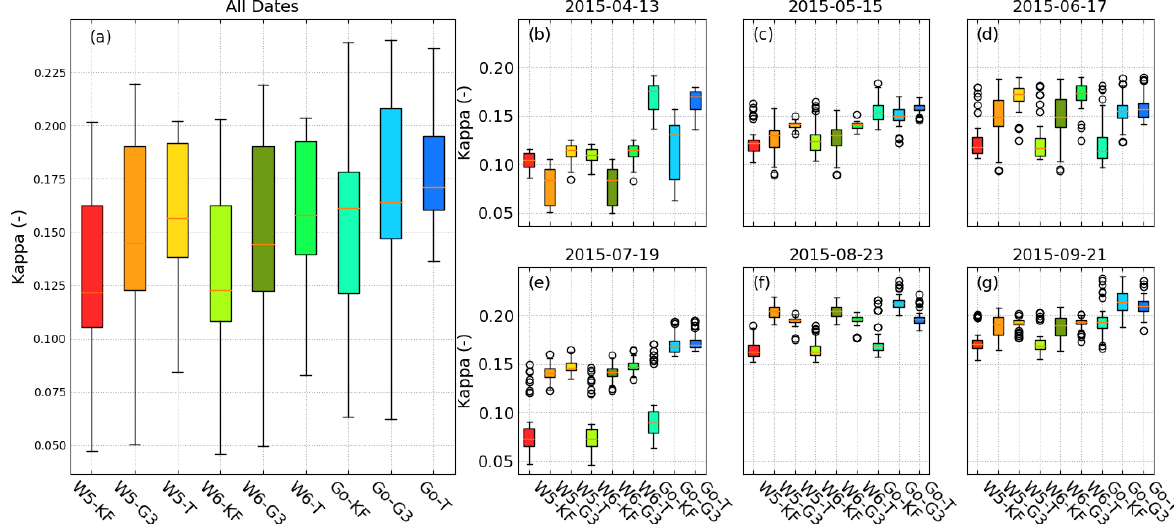
Figure 14. The box plots of κ from microphysics and cumulus parameterization clusters in panel (a) show all the simulation dates and those on (b) 13 April, (c) 15 May, (d) 17 June, (e) 19 July, (f) 23 August, and (g) 21 September for Set